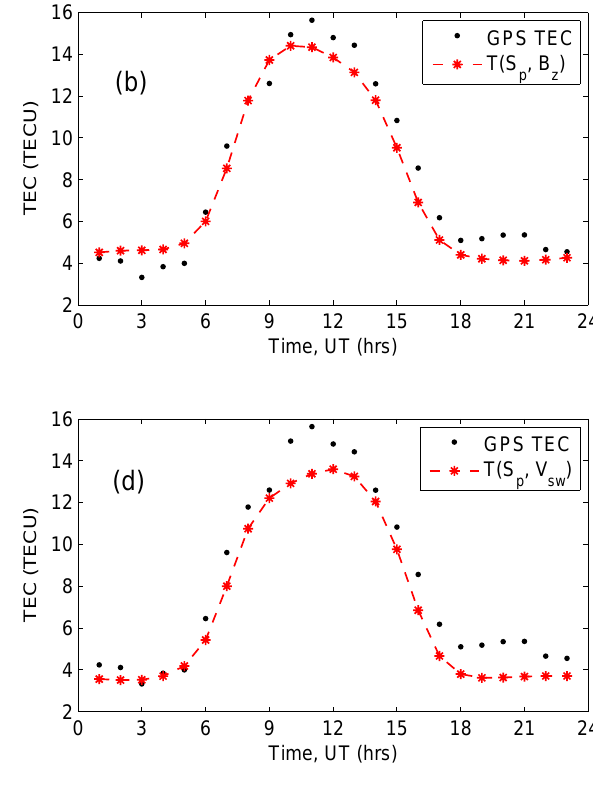
Fig. 5. Similar to Fig. 3, for day 185 in